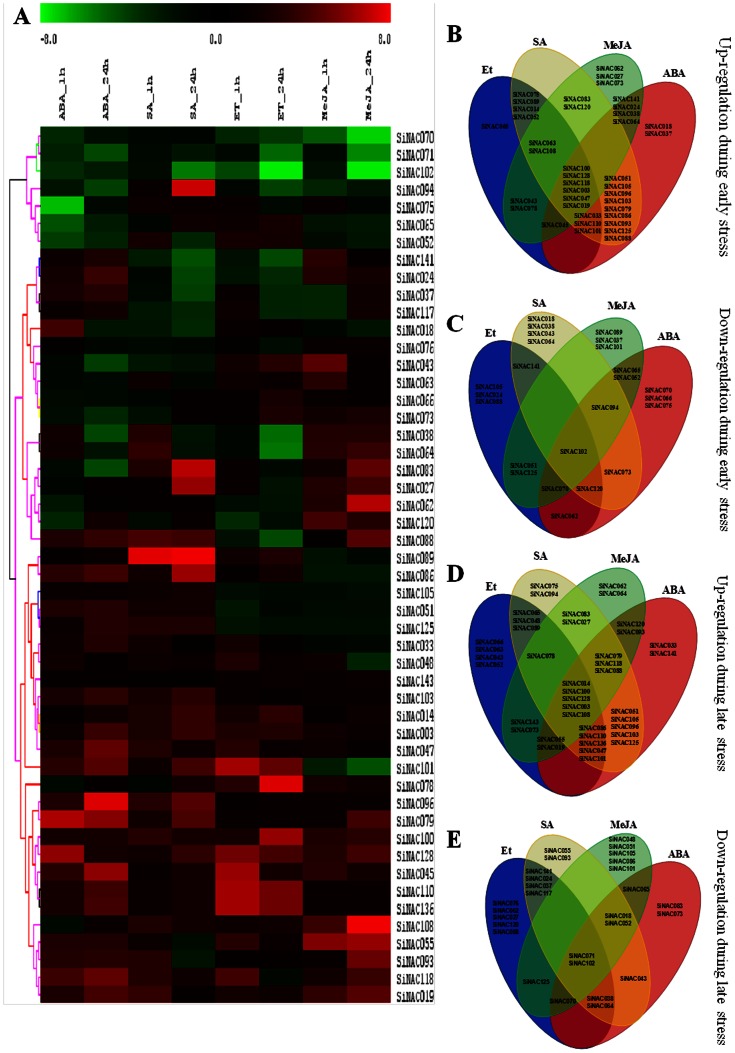
Expression profile of 50 foxtail millet NAC genes in response to various hormones.(A) Hierarchical clustering of differential gene expression in response to salicylic acid (SA), Ethephone (ET), Absissic acid (ABA) and methyl jasmonate (MeJA) stress across two time points (1 h and 24 h). The heat-map has been generated based on the fold-change values in the treated sample when compared with its unstressed control sample. The color scale for fold-change values is shown at the top. Venn diagram showing stress-specific distribution of SiNAC genes into four categories as (B) early up-regulated, (C) early down-regulated (D) late up-regulated, and (E) late down-regulated. The common subset of genes regulated by two or more stresses is marked by the overlapping circle.